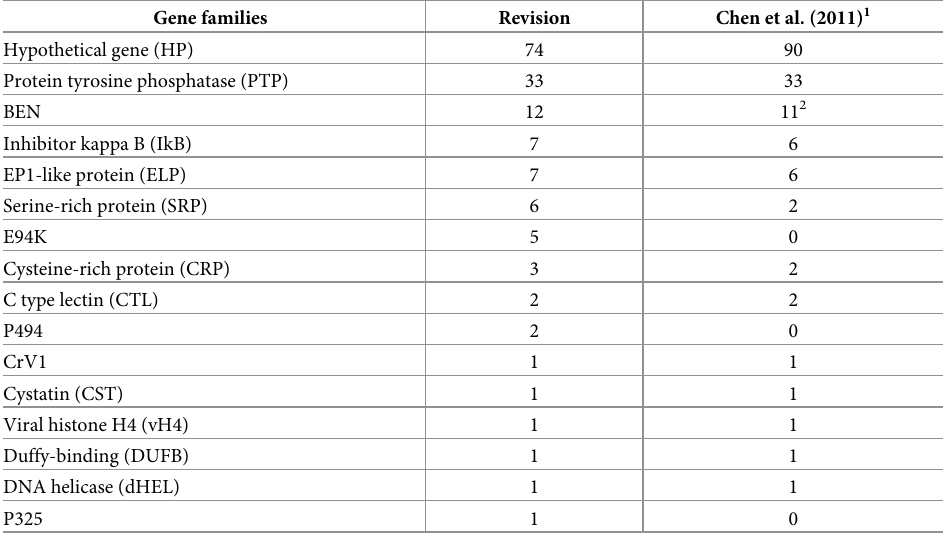
Table 1. A revised annotation of 157 CpBV ORFs from 35 circles (C1-C35). Their sequences are obtained from GenBank with accession numbers of